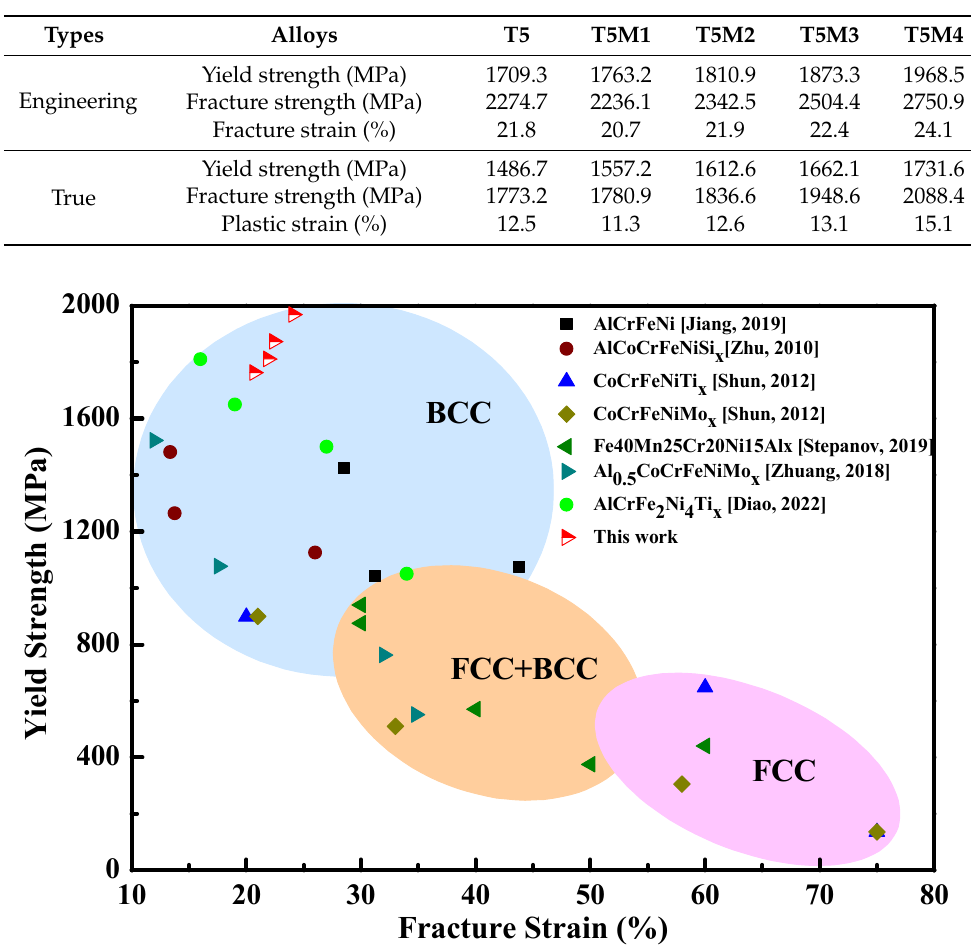
Figure 5. ( a ) Engineering stress–strain curves and ( b ) true stress–strain curves of compression tests for the HEA samples. Table 3. Effect of Mo on the mechanical properties for the AlCrFeNiTi 0.5 HEA.